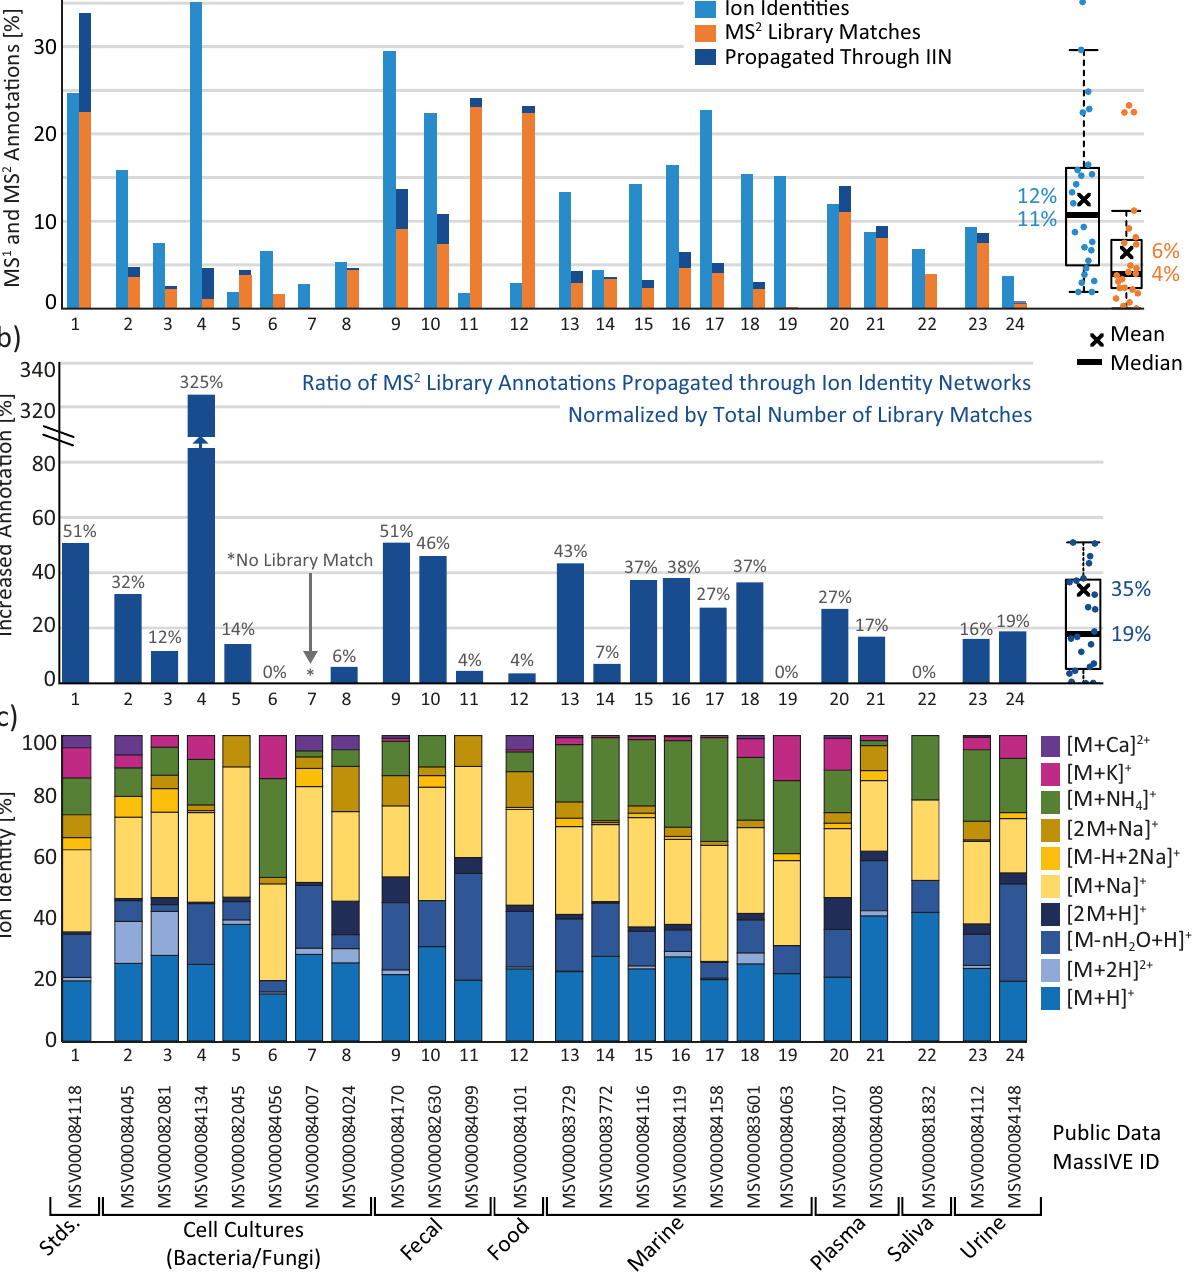
Fig. 4 Overview of IIMN results for 24 experimental datasets. a Summarizes the relative number of LC-MS features (with an MS 2 spectrum) that were annotated by ion identities or matches to the GNPS spectral libraries. The increased annotation rate by propagating library matches to connected unannotated ion identities is highlighted and b displayed as relative gains with a mean increase by 35% compared to all library matches. c Comparison of relative ion formation tendencies measured as the number of ion identities. Boxplots summarize the statistics of overall n = 24 datasets by visualizing the median as a horizontal line, the mean as an x, the fi rst and third quartile as the lower and upper hinges, and the whiskers corresponding to the minimum value below Q1 and the maximum value above Q3 within the 1.5 × IQR. Source data are provided as a Source Data fi